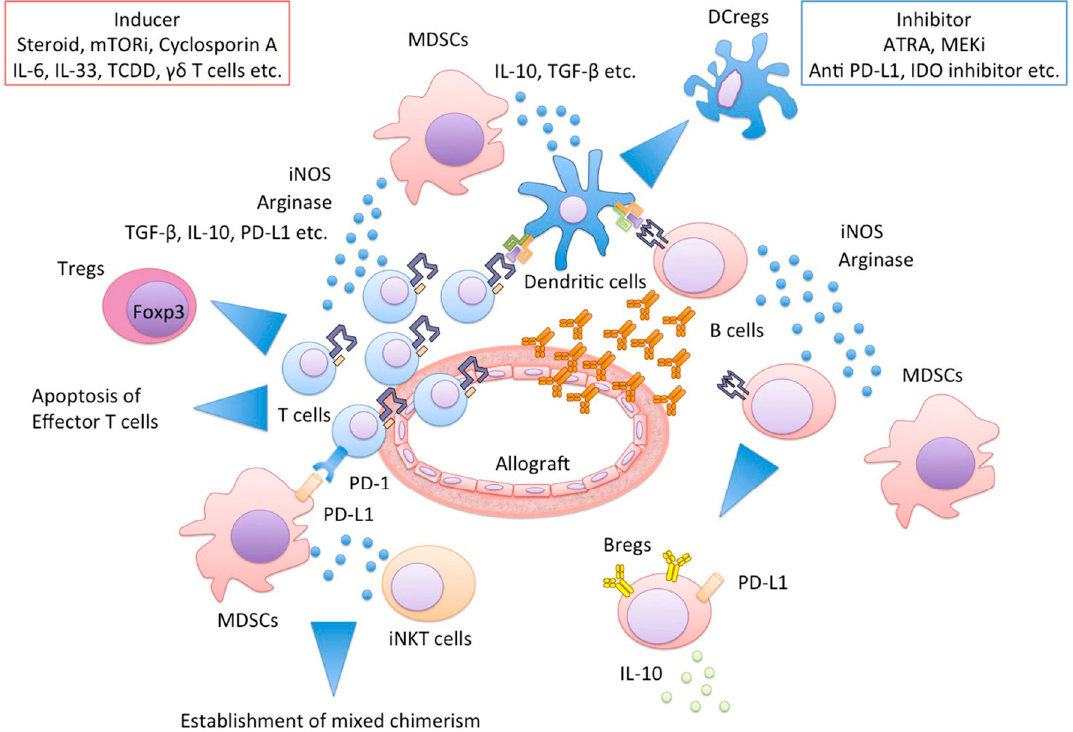
Figure 2. MDSCs and their networks cooperatively protect allograft injury. Functional MDSCs produce a large amount of iNOS or arginase, resulting in effector T cell apoptosis, Tregs and Bregs and DCregs induction. MDSCs and invariant NKT cells interactions regulate the establishment of mixed chimerism. MDSCs, myeloid ‐ derived suppressor cells; iNOS, inducible NO synthase; Tregs, regulatory T cells; Bregs, regulatory B cells; DCregs, regulatory dendritic cells; NKT, Natural Killer T cells.